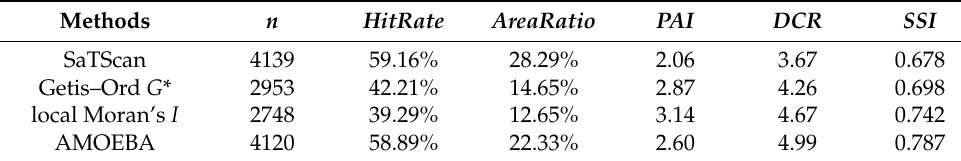
Table 3. Evaluation results of hotspots on real crime